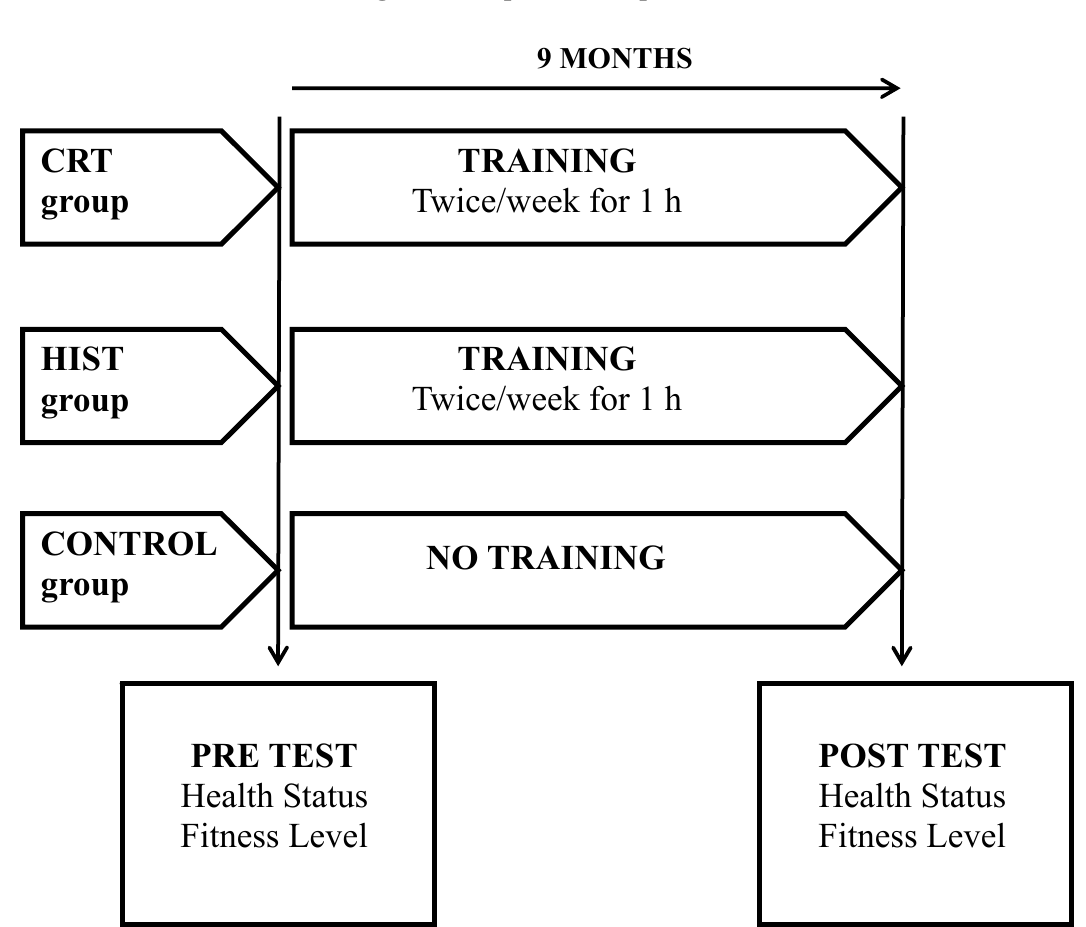
Figure 2. Experimental